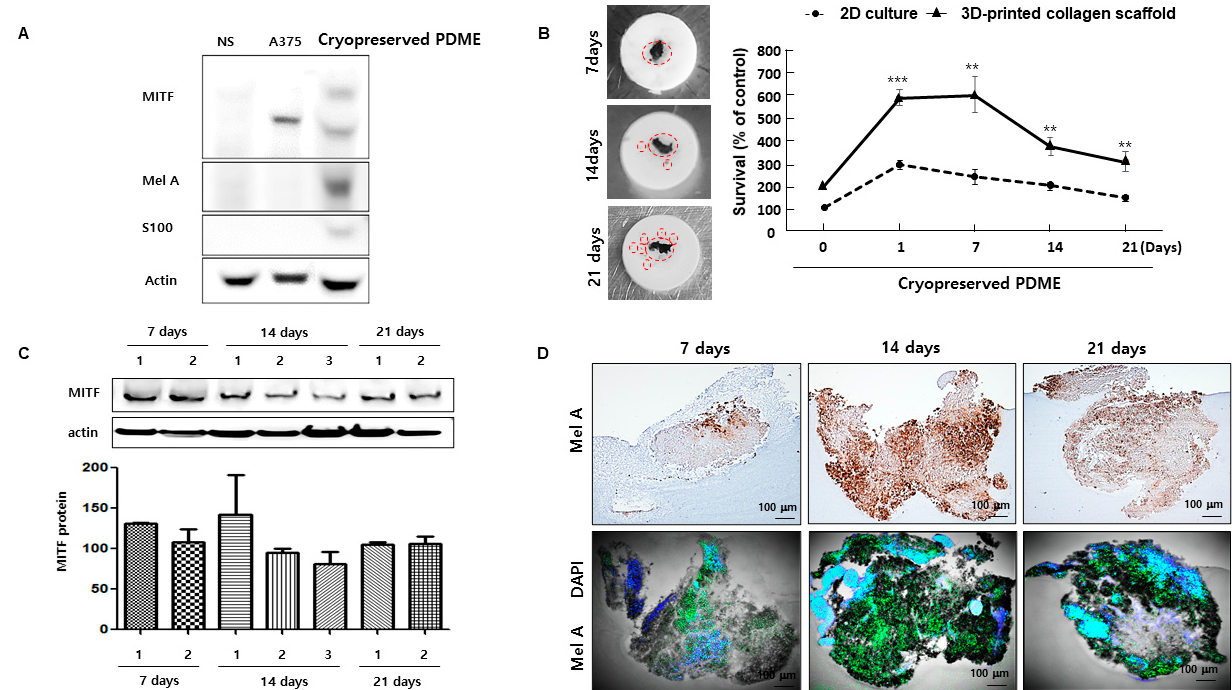
Figure 4. The effects of 3D-printed collagen scaffolds on 3D culture model of cryopreserved PDME in the maintenance of long-term culture. ( A ) Western blot analysis to detect the expression of MITF, Mel A, and S100 indicating the expression of NK, A375, and 3D-printed collagen scaffolds loaded with cryopreserved PDME after thawing. ( B ) Representative images of 3D-printed collagen scaffolds loaded with cryopreserved PDME at 7, 14, and 21 days. The graphs indicate the proliferation of the 2D-cultured and 3D-printed collagen scaffolds at the indicated time points. Red circles show cryopreserved PDME and its satellite. All data were obtained from three independent experiments, and values represent the mean ± SD. For all groups ** p < 0.01, *** p < 0.001 versus 2D-cultured at the indicated time points using Student’s t -test. ( C ) Western blot analysis for expressing MITF protein at the indicated time points. The graph indicates densitometry and statistical analysis of MITF protein expression gathered from twice experiments of western blot assay. ( D ) Immunohistochemisty (IHC) and immunofluorescence staining (IFS) analysis for maintaining the function of 3D-printed collagen scaffold laded with cryopreserved PDME at the indicated time points. Mel A(green), DAPI(blue), Overlay of Mel A and DAPI(bright blue). Scale bars, 100 μ m.